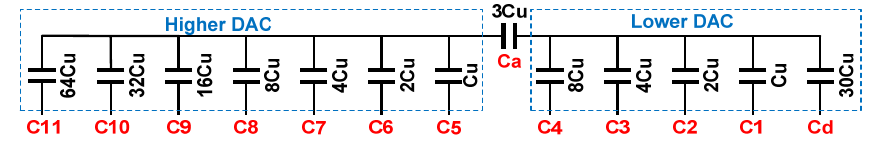
Figure 8. Conventional bridge capacitor array.